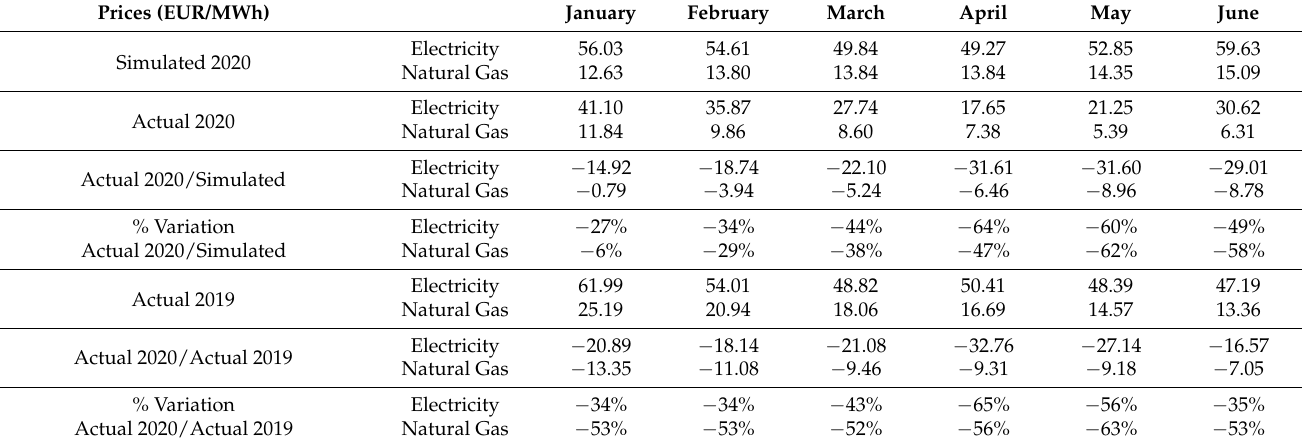
Table 5. Actual prices for first half of 2019 and 2020 and expected prices for first half of 2020. Prices